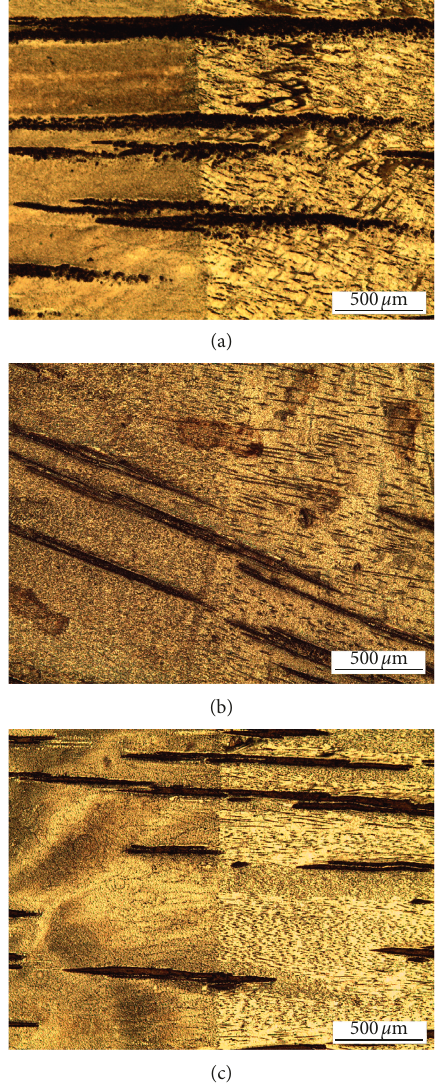
Figure 2: Longitudinal view of Sn-7 wt.% Cu samples directionally grown at increasing values of pulling velocity: (a) 1.0 µ m/s; (b) 2.0 µ m/s; (c) 5.0 µ m/s ( G L �